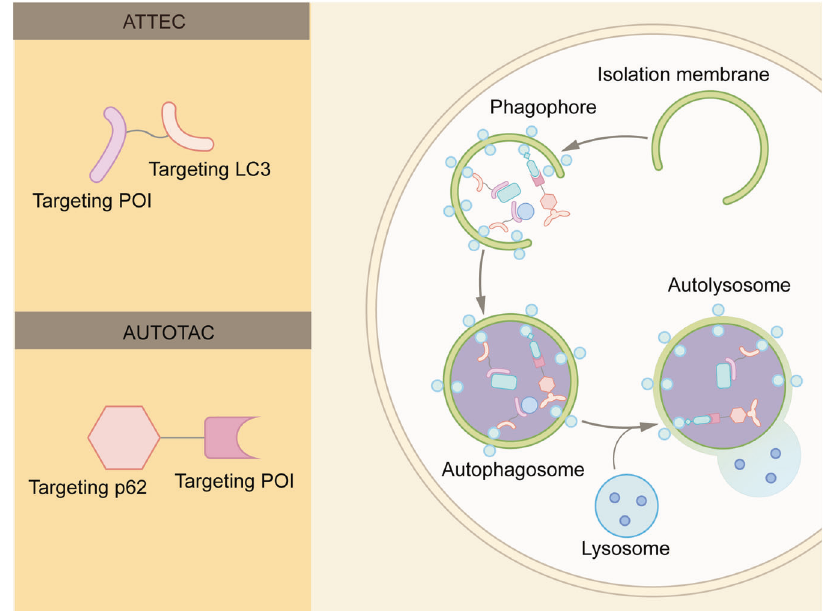
Fig. 11 Schematic representation of ATTEC and AUTOTAC. An ATTEC molecule simultaneously binds LC3 and a POI, while an AUTOTAC molecule binds p62 and a POI. The binding induces the formation of autophagosomes, and subsequent fusion between autophagosomes and lysosomes lead to the POI